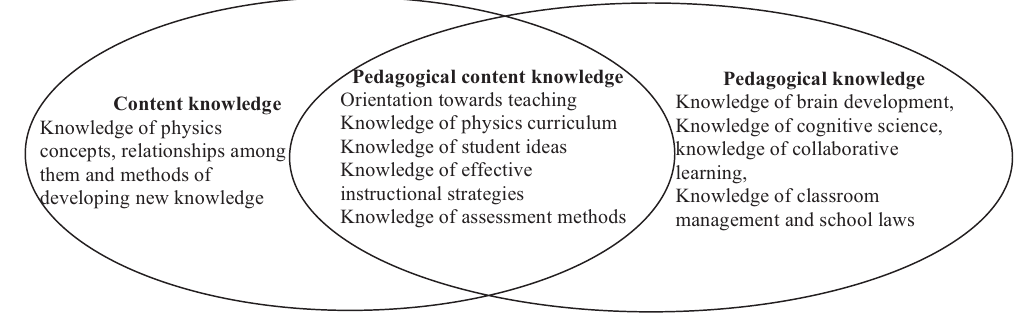
FIG. 1. The Structure of Physics